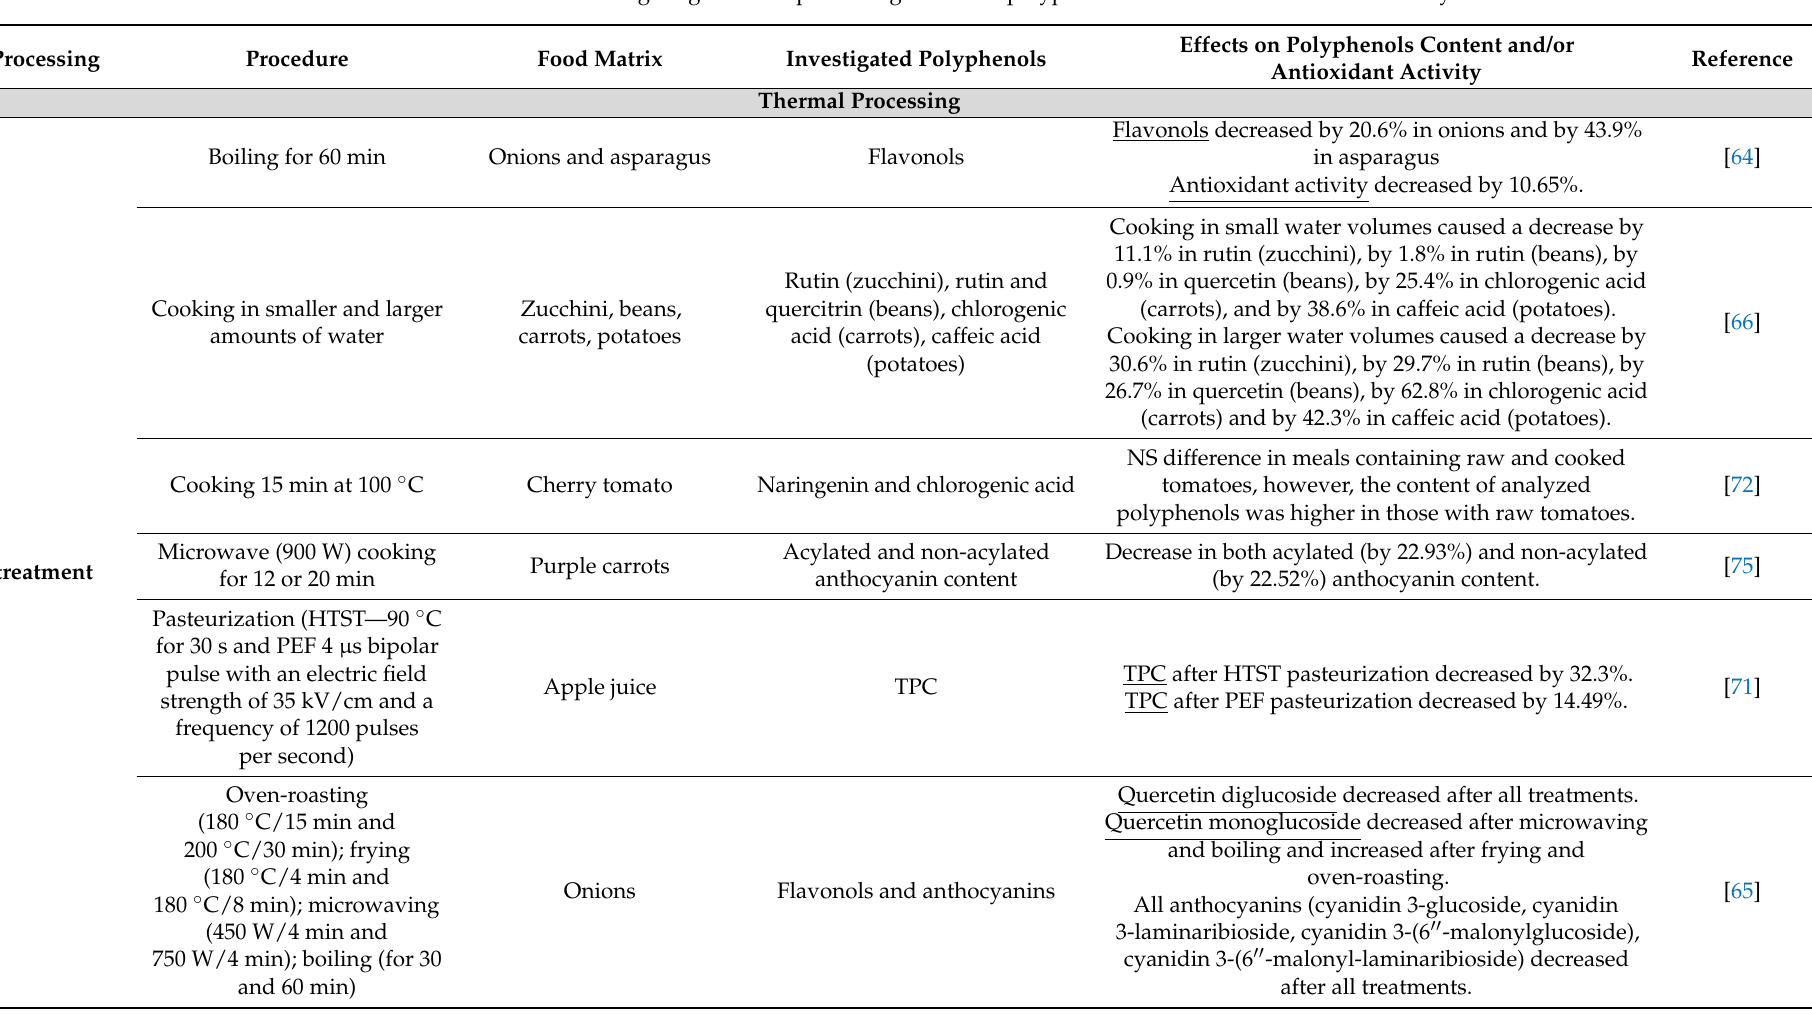
Table A1. Overview of studies investigating the food-processing effects on polyphenols content and antioxidant